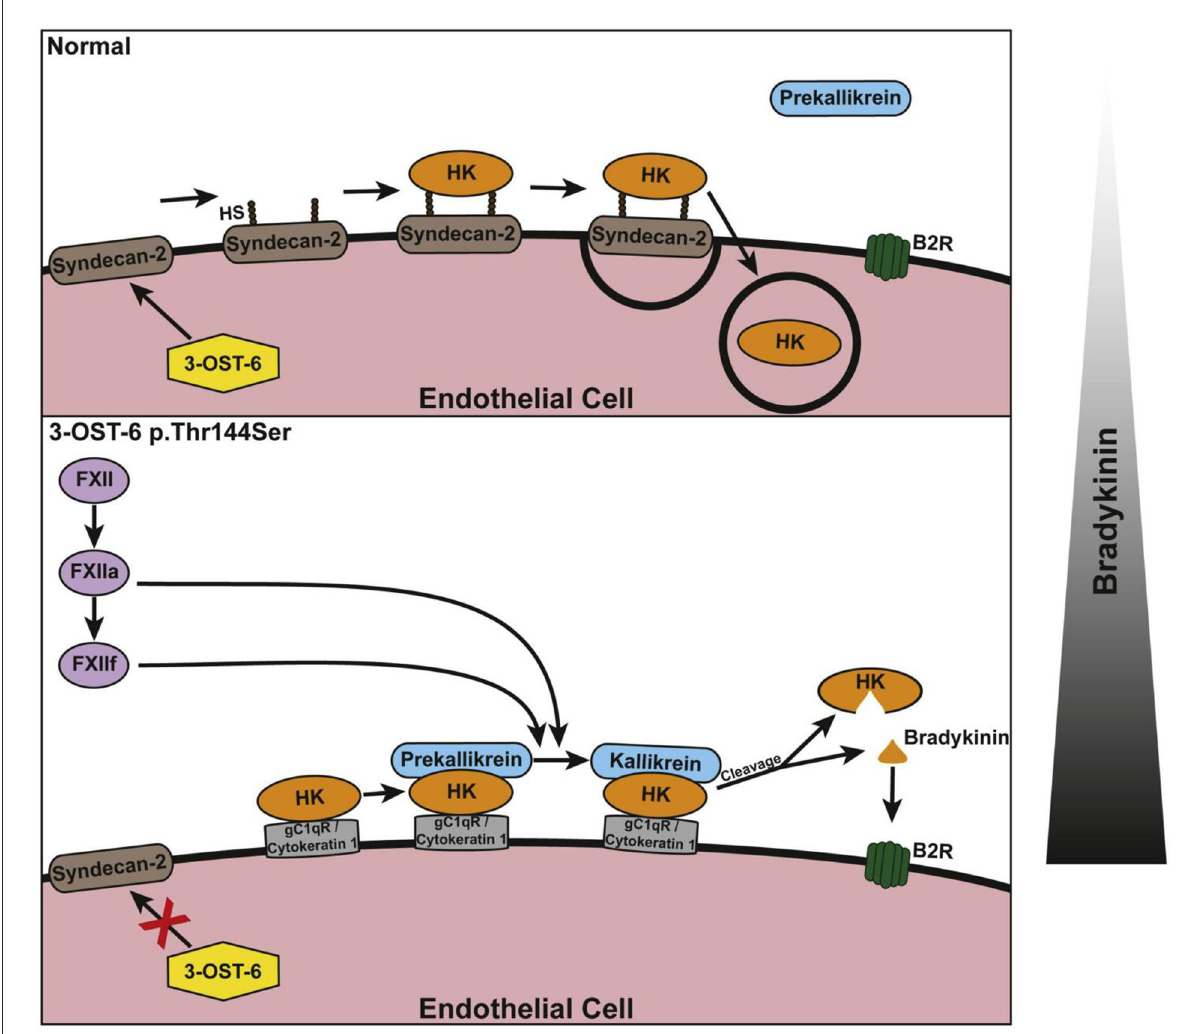
FIGURE8 Schematic of the suggested involvement of 3-OST-6 in HK docking on the endothelial cell surface. The upper panel shows the normal (wild type) situation with HK being taken up via endocytosis due to interaction with heparan sulfate (HS)-containing proteoglycans. This prevents cleavage and bradykinin production. The lower panel shows the mutant situation: Because of incomplete HS modification, HK interacts with alternative interaction partners on the cell surface. This does not result in endocytosis and allows for HK cleavage and increased bradykinin production. The bar at the right indicates a shift in the balance of bradykinin production. Reproduced with permission: Bork et al. (60).